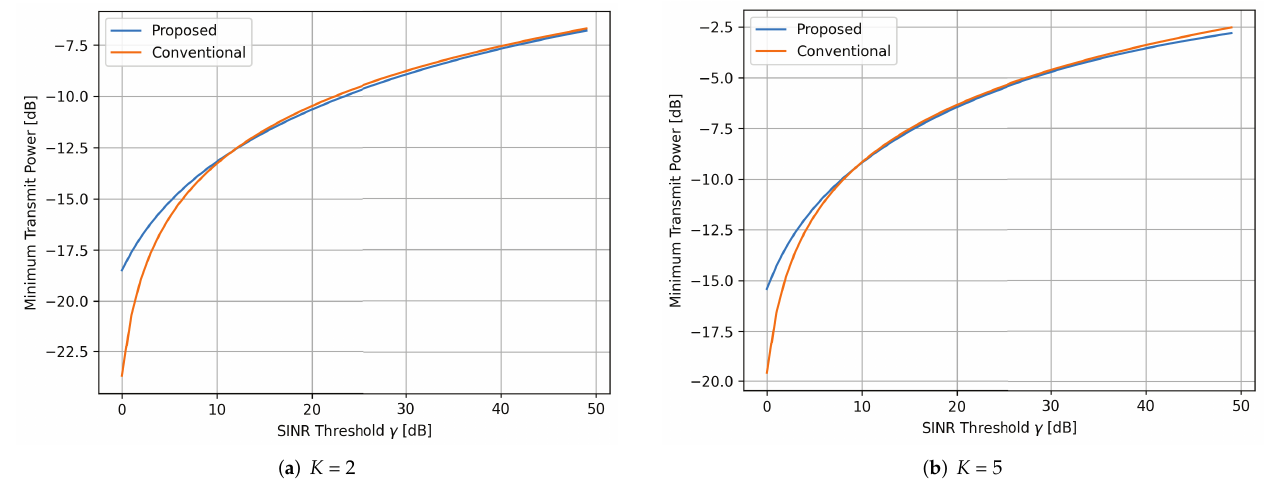
Figure 8. Minimum transmit power versus the SINR threshold for the uplink with v = 160